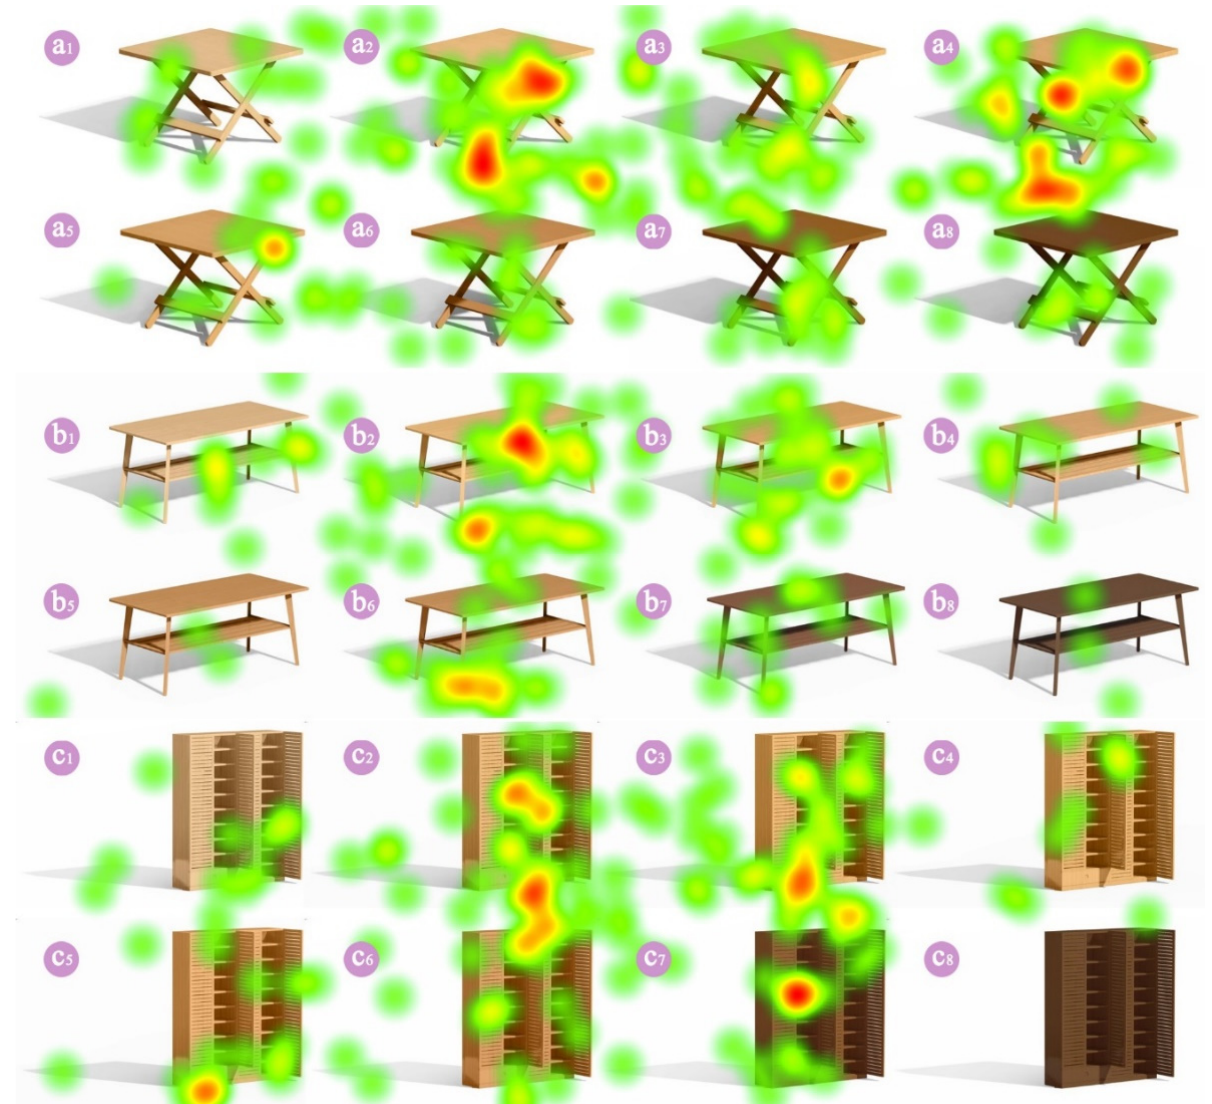
Figure 5. The hot-spot map of different types of bamboo furniture. Bamboo (near the outer layer) after thermal treatment with tung oil for 3h: ( a 1 – c 1 ) untreated, ( a 2 – c 2 ) 23 °C, ( a 3 – c 3 ) 100 °C, ( a 4 – c 4 ) 120 °C, ( a 5 – c 5 ) 140 °C, ( a 6 – c 6 ) 160 °C, ( a 7 – c 7 ) 180 °C and ( a 8 – c 8 ) 200 °C. 120 ◦ C, ( a 5 – c 5 ) 140 ◦ C, ( a 6 – c 6 ) 160 ◦ C, ( a 7 – c 7 ) 180 ◦ C and ( a 8 – c 8 ) 200 ◦